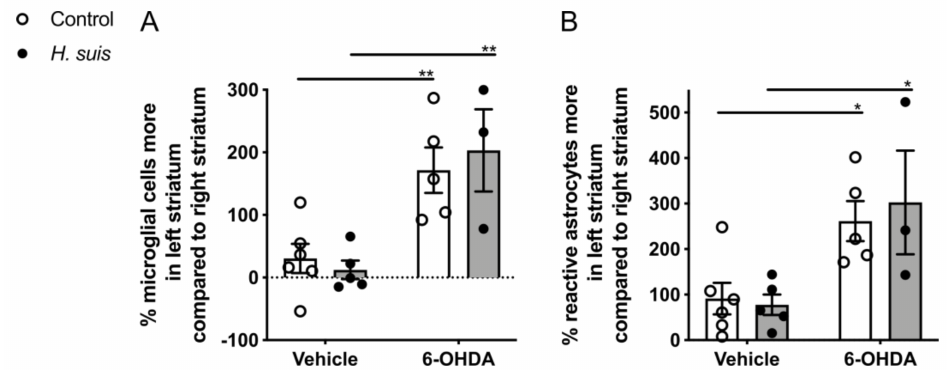
Figure 6. 6-hydroxydopamine (6-OHDA) induced gliosis is not influenced by short-term Helicobacter suis ( H. suis ) infection. ( A ) Percentage (%) of IBA1-positive microglial cells more in the left injected striatum compared to the right non-injected striatum based on manual analysis, 7 days after intrastri- atal injection with either 6-OHDA (n = 3–5) or vehicle (n = 5–6), of mice infected with H. suis (black) or the control broth (white) for a short-term period. ( B ) Percentage (%) of GFAP-positive astrocytes more in the left injected striatum compared to the right non-injected striatum based on automated analysis, 7 days after intrastriatal injection with either 6-OHDA (n = 3–5) or vehicle (n = 5–6), of mice infected with H. suis (black) or the control broth (white) for a short-term period. * 0.01 ≤ p < 0.05; ** 0.001 ≤ p <